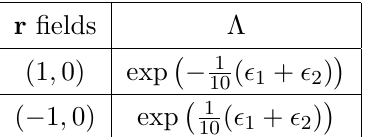
Table 4 . The non-equivalent unity r (cid:12)elds and (cid:3) of resolved C 3 = Z